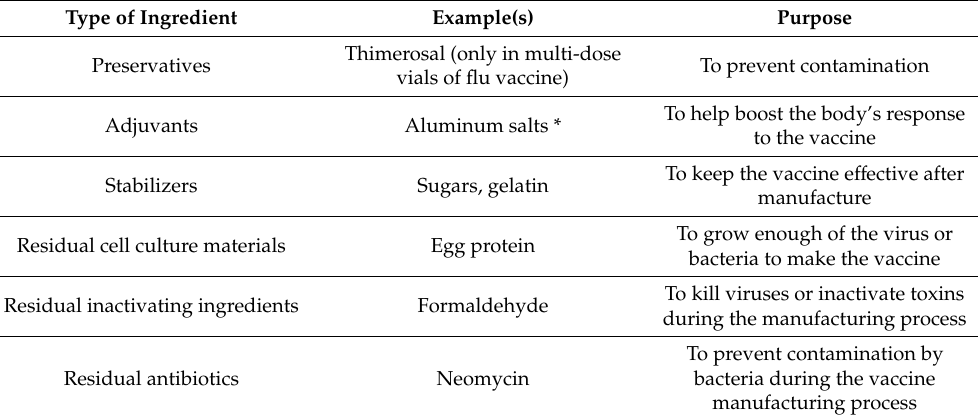
Table 1. Key components of approved vaccines in the U.S. reproduced from the CDC [46].